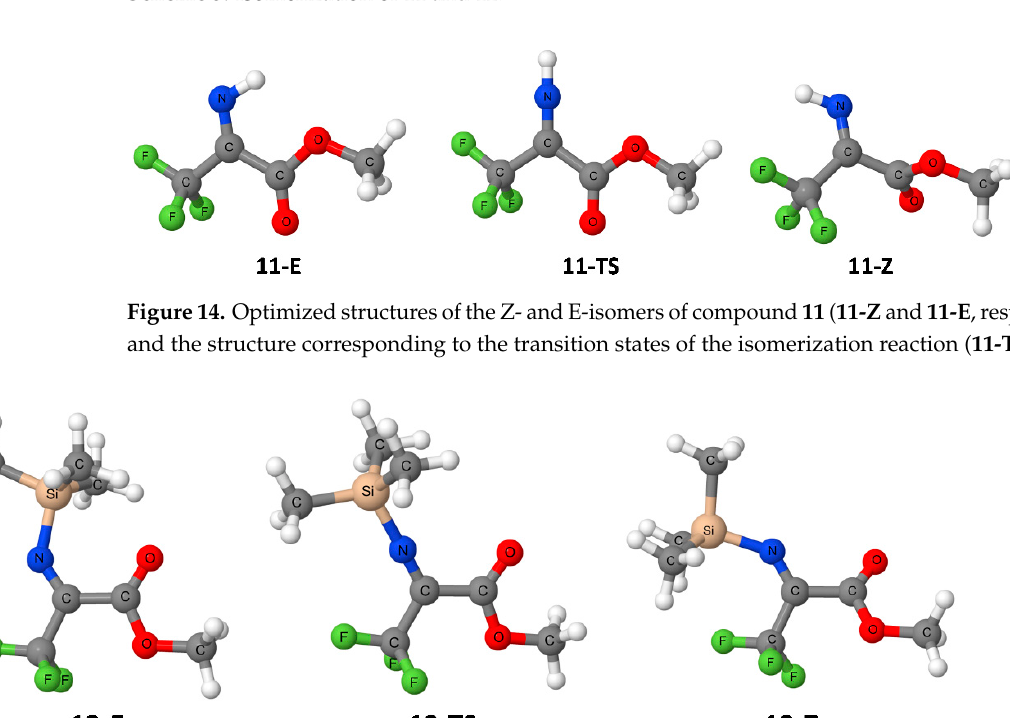
Scheme 5. Isomerization of 11 and 12 .